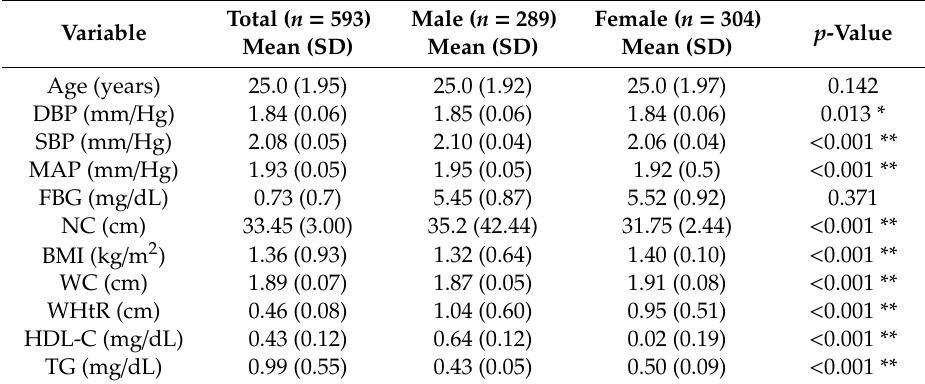
Table 1. Characteristics of the study participants presented as mean and SD. Variable